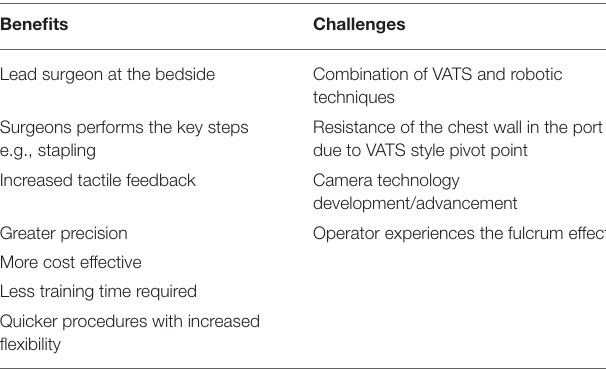
TABLE 1 | Benefits and current challenges of wristed-instrument technology.